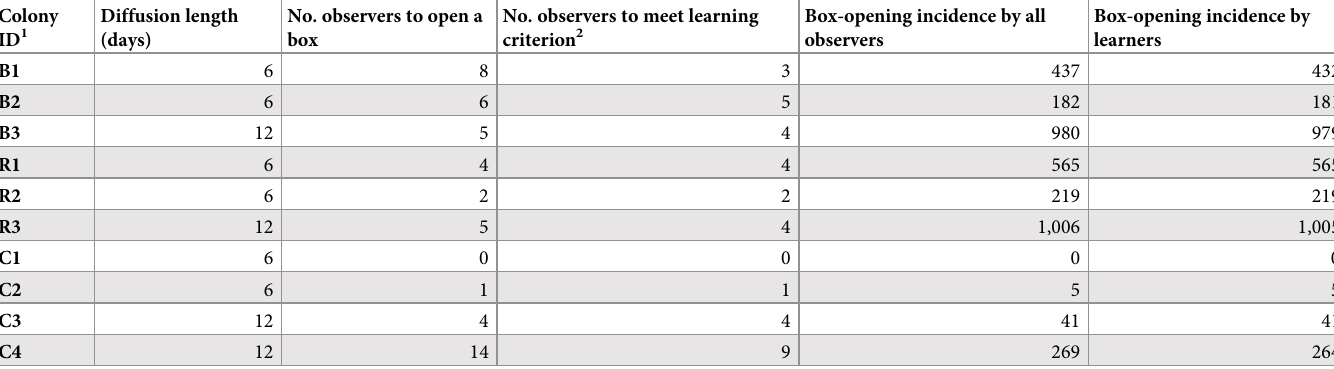
Table 1. Number of untrained bees to open the puzzle box and meet learning criteria in the single-demonstrator diffusion experiments. Diffusion length Colony (days) ID 1